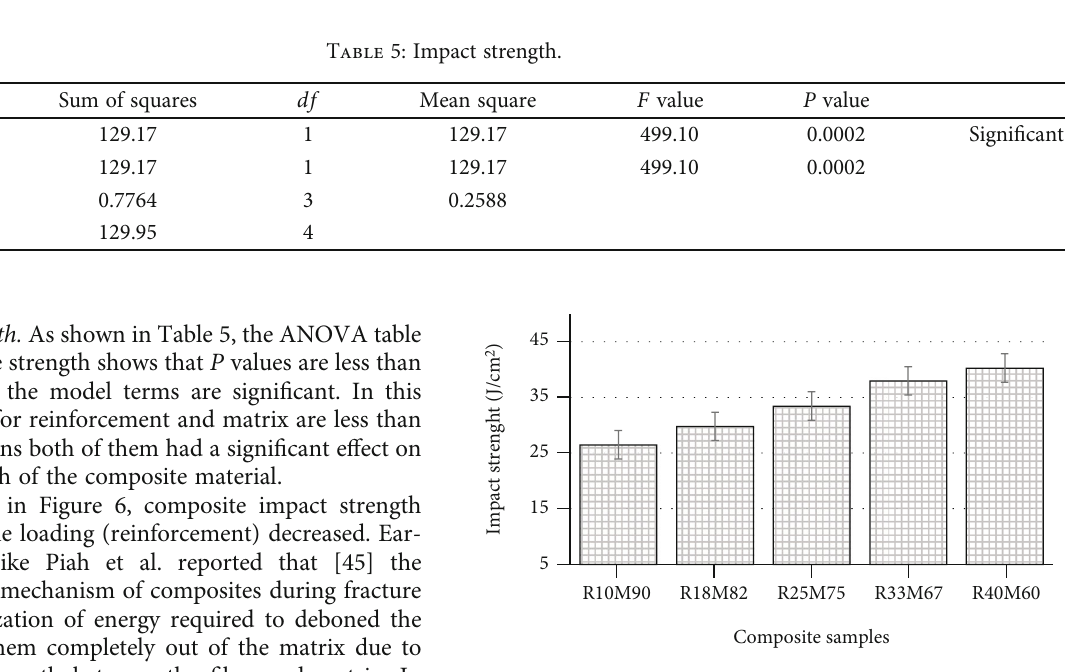
Figure 6: Impact